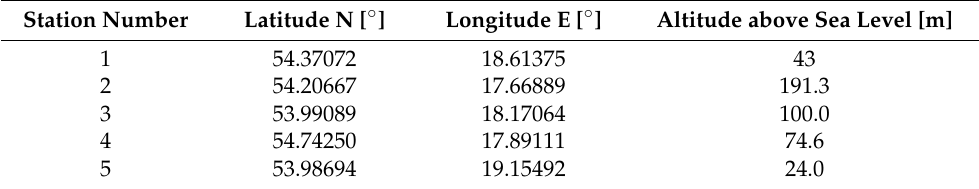
Table 1. Reference station positions in the